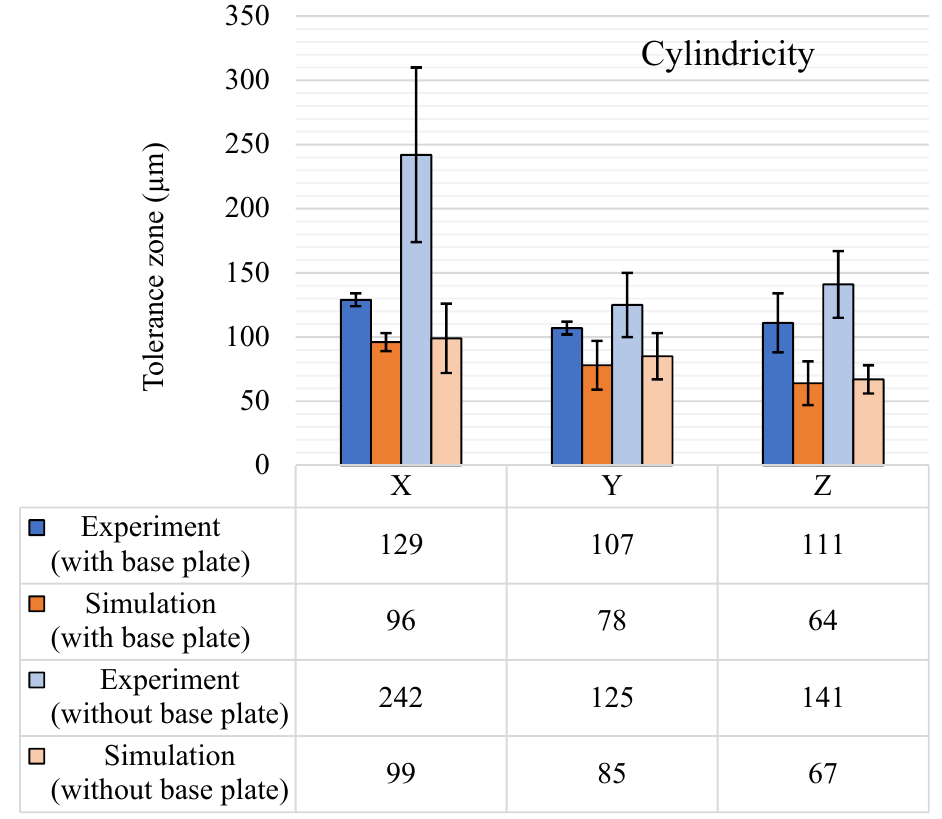
Figure 11. Cylindricity ( µ m) tolerance results, with and without the base plate.